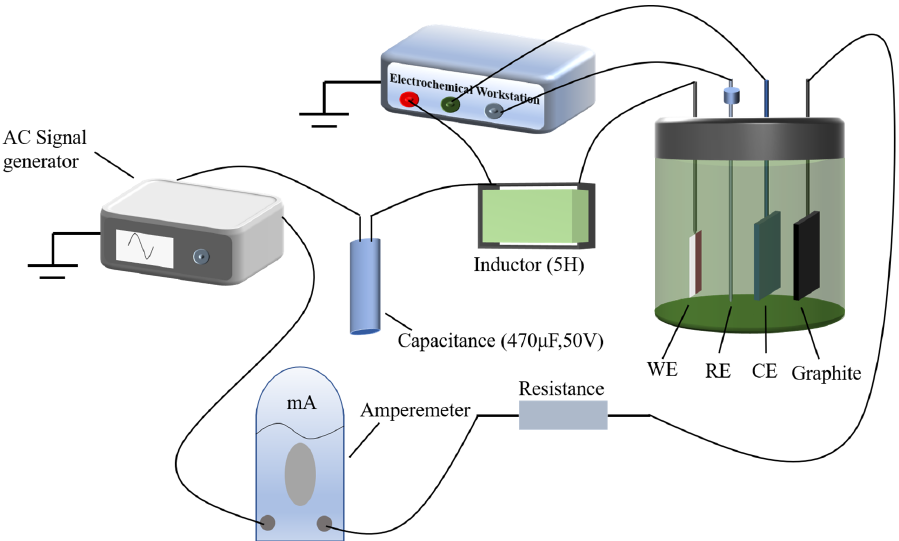
Figure 3. Schematic diagram of the electrochemical tests for coupled steel–copper electrodes with interference of different AC intensities in simulated acidic soil solution.